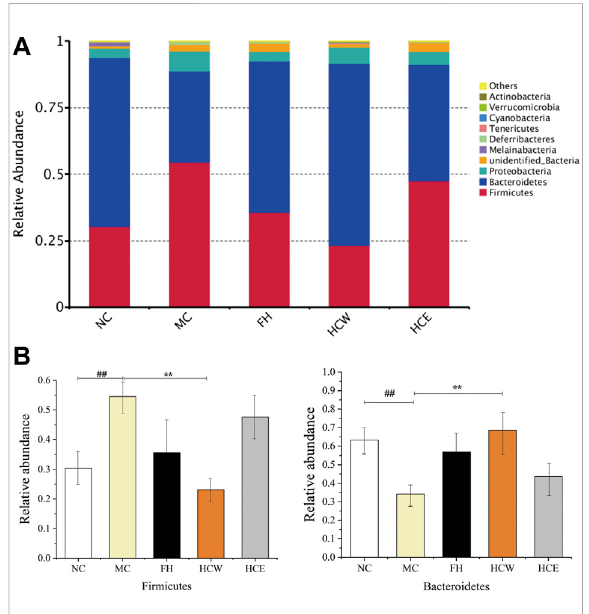
FIGURE 8 Comparison of the relative abundance of intestinal fl ora at the genus level (A) . Comparison of Bacteroides and Desulfovibrio relative abundance in different groups (B) . Data are reported as mean ± SD. For statistical signi fi cant, # p < 0.05 compared with the normal control group; * p < 0.05 compared with the model control group. NC, normal group; MC, model group;